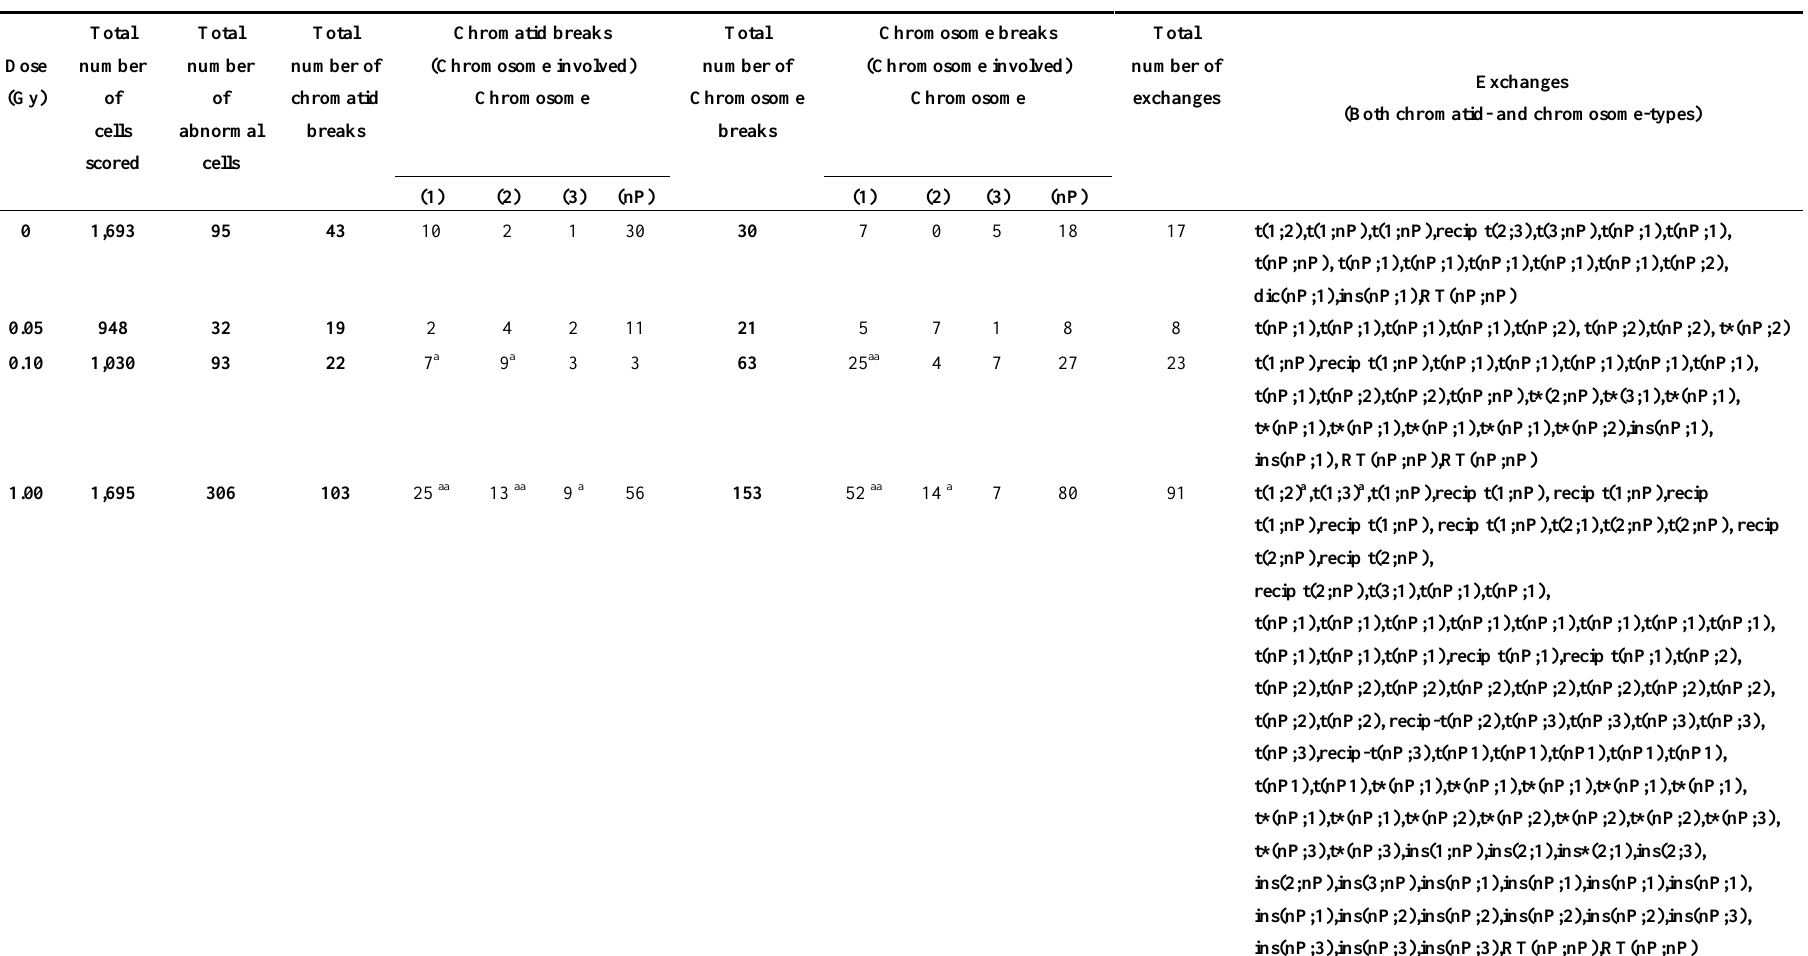
t Translocation (incomplete, chromosome-type), t* Translocation (incomplete chromatid-type, recip t Reciprocal translocation, RT Robertsonian translocation, dic Dicentric, ins Insertion, nP non-painted chromosome; a clones of cells with a specific type of aberration occurring on a specific chromosome found in one mouse; aa cl ones of cells with a specific type of aberration occurring on a specific chromosome found in two